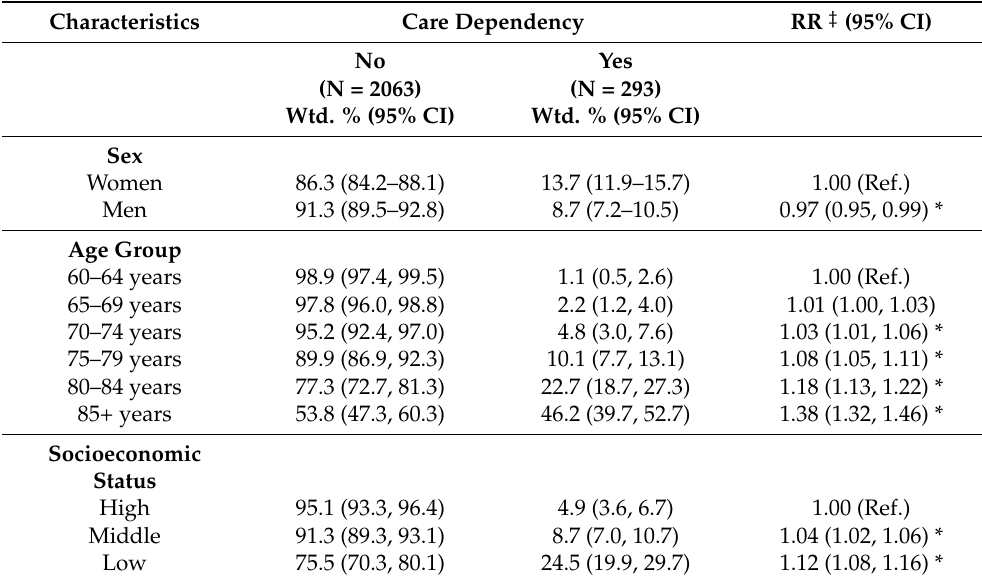
Table 6. Care dependency of LAB60+ participants, after weighting, by age group, gender, and socioeco- nomic status